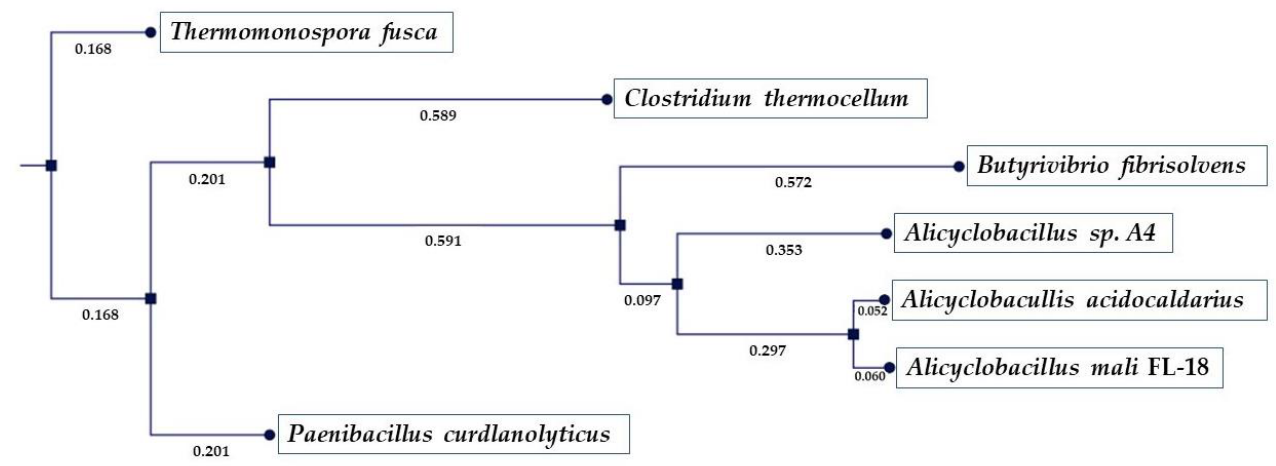
Figure 3. Phylogenetic tree by CLC Main Workbench 22.0.2. The numbers on the nodes correspond to the percentage of bootstrap values for 200 replicates.